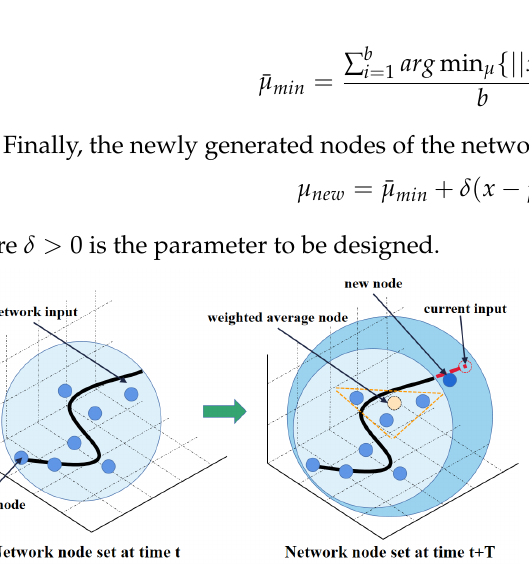
Figure 1. The schematic diagram of the incremental neural